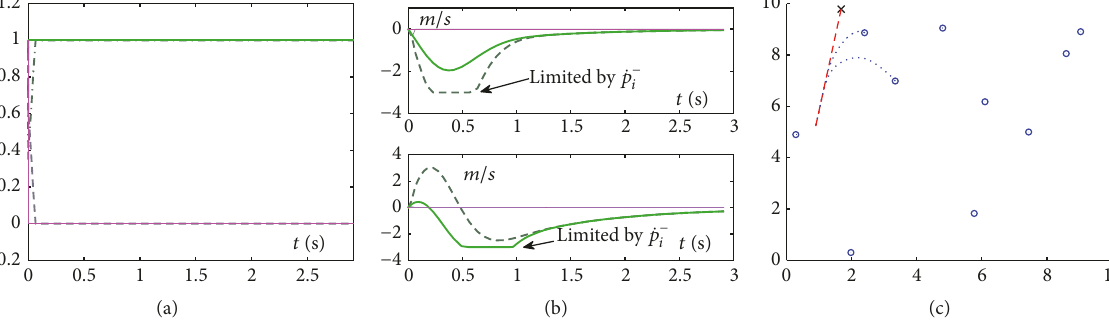
Figure 10: Performance of 𝑘 -WTA network in distributed coordination model with 𝑘 = 2 , zero-initial-velocity constraint, as well as bound limits on velocity of mobile robots. (a) Outputs of 𝑘 -WTA network with 𝑘 = 2 . (b) Velocities of mobile robots. (c) Tracking trajectories of different mobile